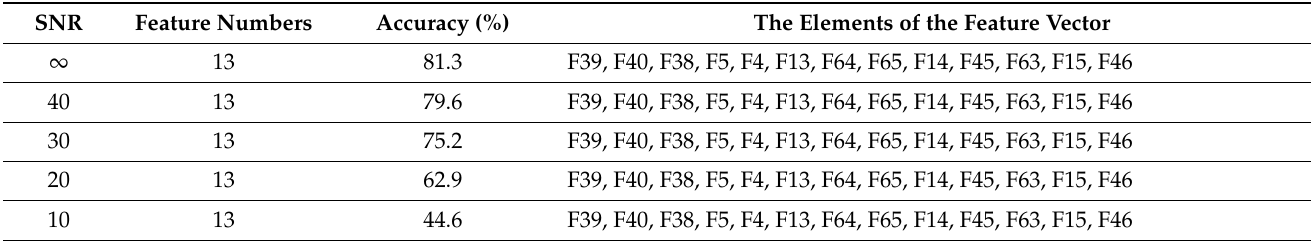
Table 9. Result of the HHT–CFS.